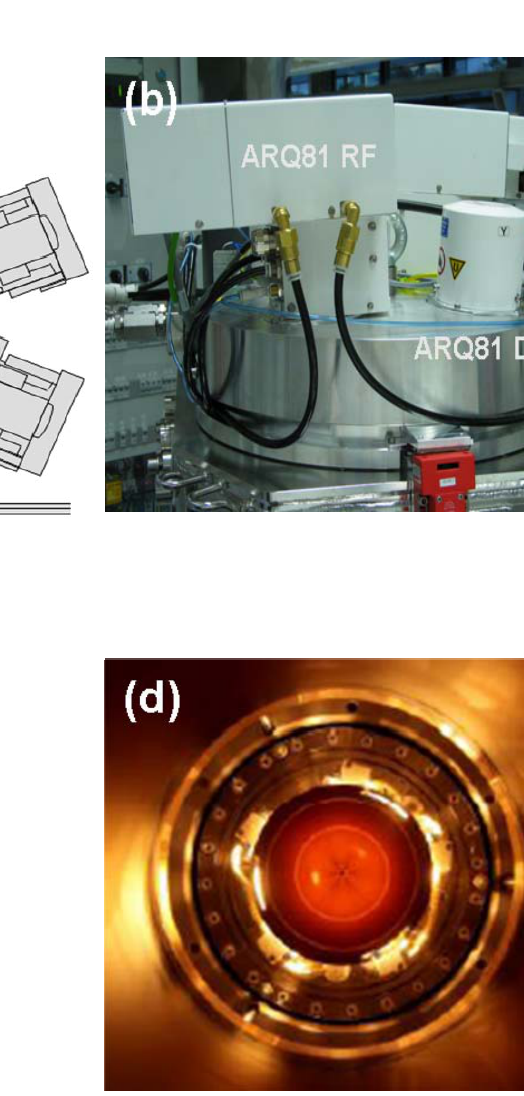
Figure 1. (a) Schematic of Oerlikon ClusterLine 200 II used for this work. (b) External view of Oerlikon MSQ showing independently powered sources, two RF, two pulsed DC. (c) Internal view of multiple targets and source shield. (d) Top down view of very hot rotating chuck at